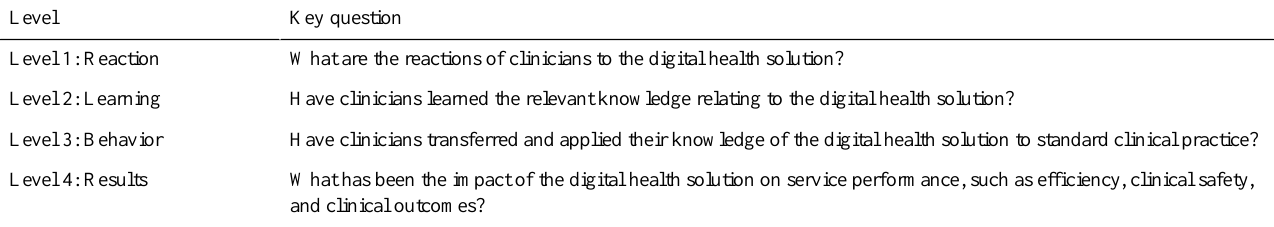
Table 1. Applying the Kirkpatrick Evaluation Model as an evaluation framework for the education and training